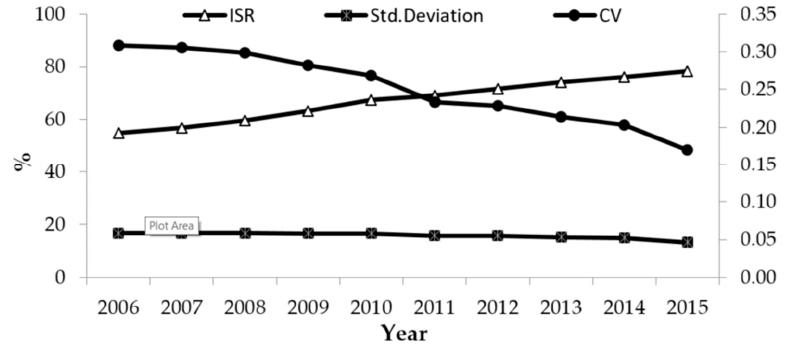
Figure 1. ISR, Standard Deviation and Coefficient of Variation of ISR during the period 2006–2015.